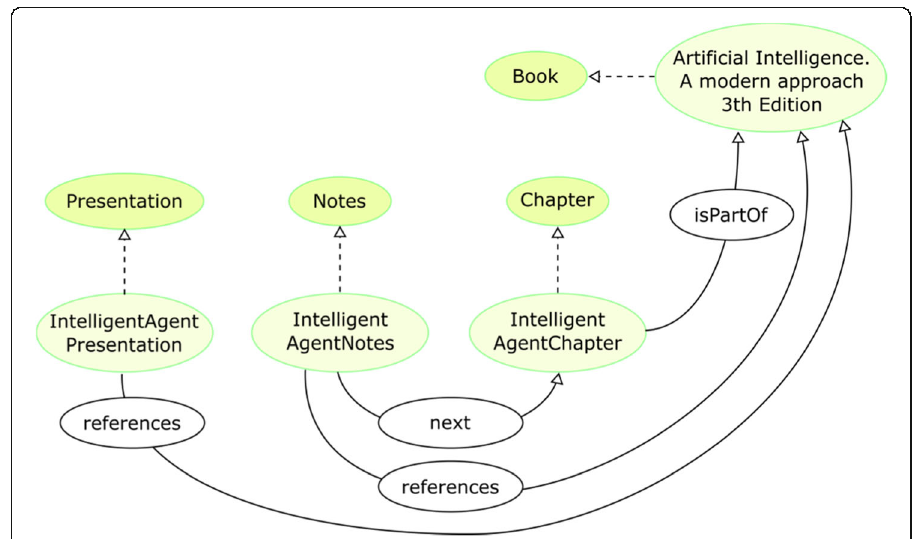
Fig. 4 Example of instances in the Educational Resources